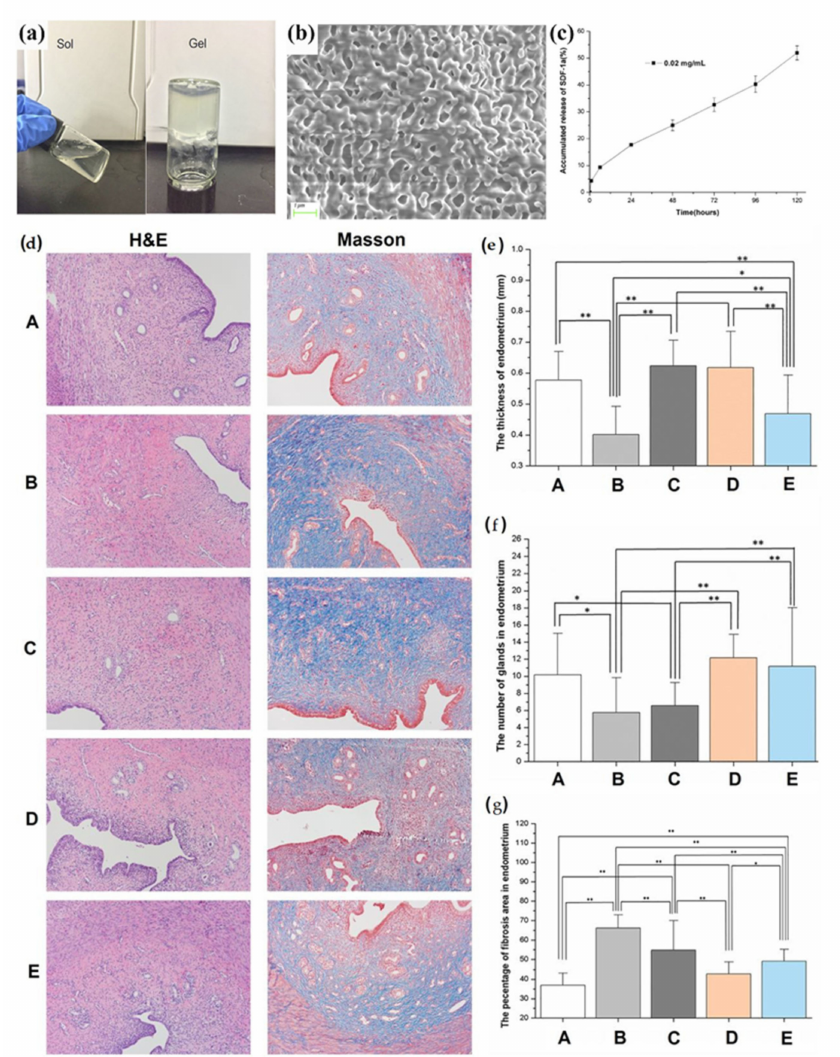
Figure 4. ( a ) Chitosan–heparin solution and chitosan–heparin hydrogel; ( b ) scanning electron micro- scope image of lyophilized chitosan–heparin delivery system; ( c ) in vitro releasing curves of SDF-1 α in chitosan–heparin delivery system; ( d ) hematoxylin and eosin staining and Masson trichrome stain- ing of uterus tissue at 7 days after surgery; The endometrial thickness ( e ), numbers of glands ( f ), and fibrosis area ( g ) of uterus in group A–E at 7 days after surgery. For statistical significance, ** p < 0.01 and * p < 0.05. A, control group; B, no treatment group; C, hydrogel only treated group; D, SDF-1 α hydrogel treated group; E, SDF-1 α treated group; SDF-1 α , stromal cell-derived factor-1 α ; H&E, hematoxylin and eosin staining. Adapted with permission from [112], published by Elsevier,